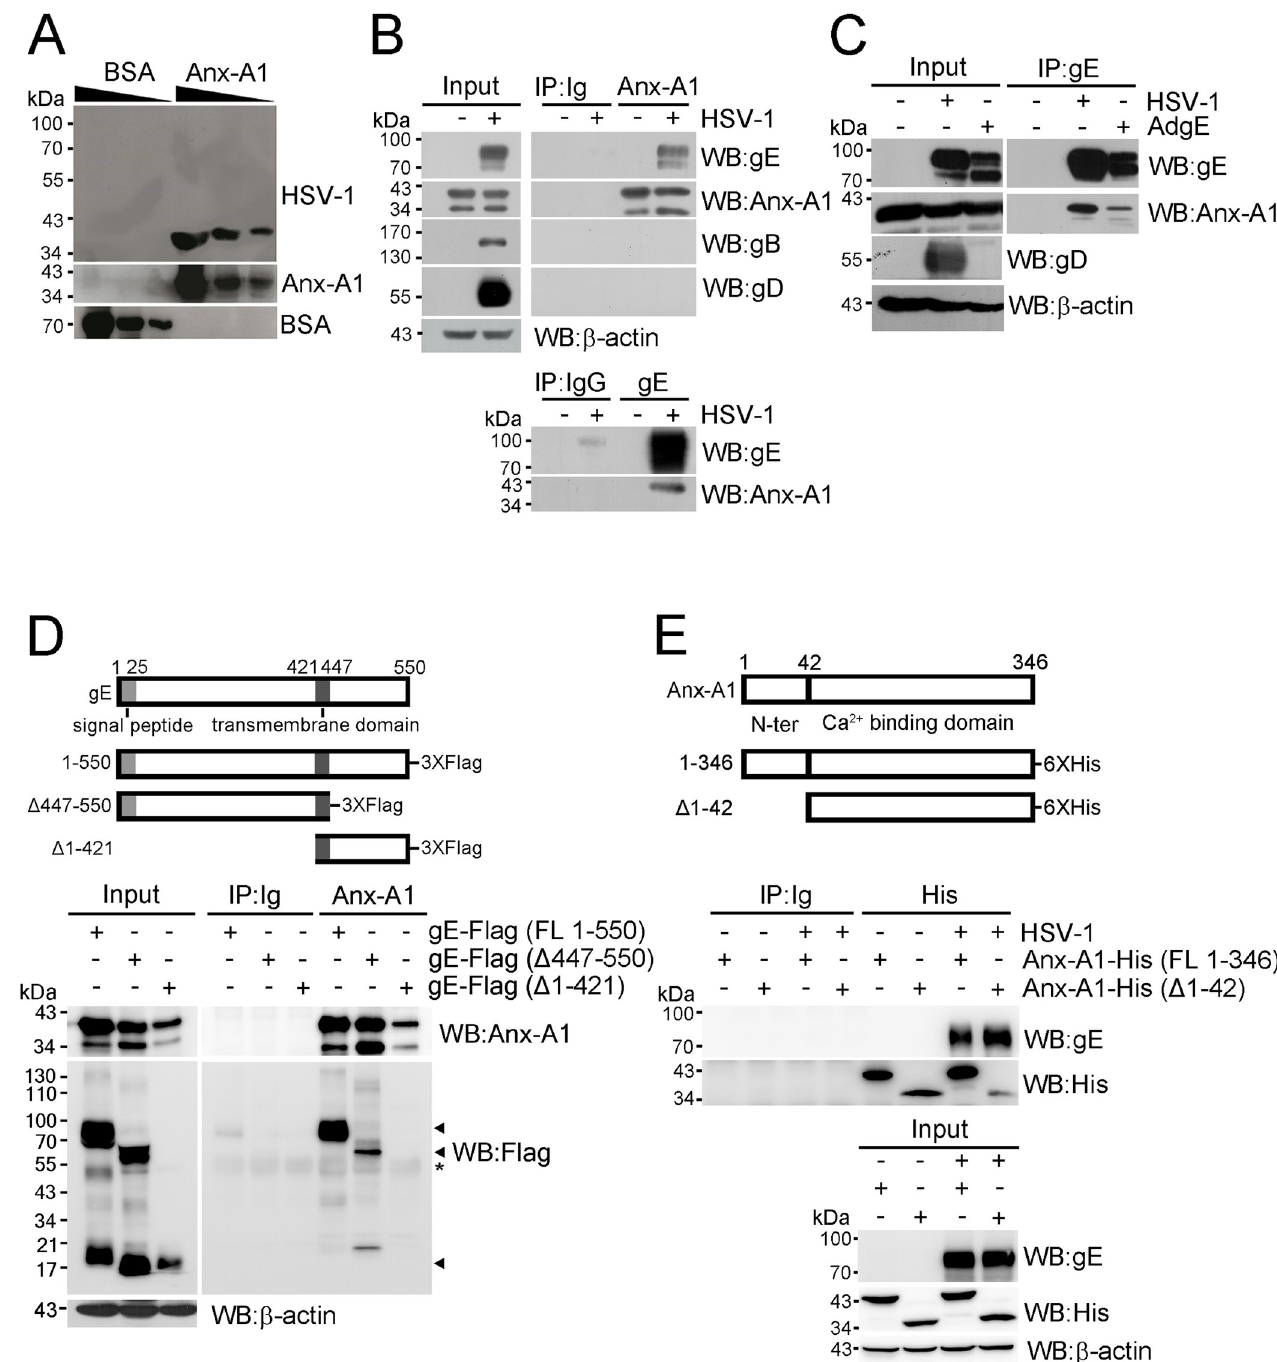
Fig 3. Anx-A1 interacts with HSV-1 gE. ( A ) A virus overlay protein binding assay was performed with reducing doses of BSA and His-tagged Anx-A1 (25, 5, and 1 μ g) on the membrane before incubation with purified HSV-1 and blotting with the indicated Abs. ( B ) The lysates of A549 cells mock-infected (-) or infected with HSV-1 (+) were subjected to western blotting (Input) or immunoprecipitated (IP) with control Abs (Ig or IgG) or Abs against Anx-A1 or gE before blotting as indicated. ( C ) The lysates of 293 cells mock-infected (-) or infected with HSV-1 (+) or the adenovirus expressing HSV-1 gE (AdgE) were subjected to western blotting (Input) or IP with anti-gE Ab before blotting as indicated. ( D ) A schematic diagram of the Flag-tagged gE deletion constructs is shown in the top panel. The lysates of 293 cells transfected with the indicated Flag-tagged gE constructs were subjected to western blotting (Input) or IP with control or anti-Anx-A1 Ab before blotting as indicated. Black triangles indicate Flag-tagged gE. � indicates heavy chains of Ab. ( E ) A schematic diagram of His- tagged Anx-A1 deletion constructs is shown in the top panel. The lysates of 293 cells transfected with the indicated His-tagged Anx-A1 constructs and mock- infected (-) or infected (+) with HSV-1 were subjected to western blotting (Input) or IP with control or anti-His Ab before blotting as indicated.